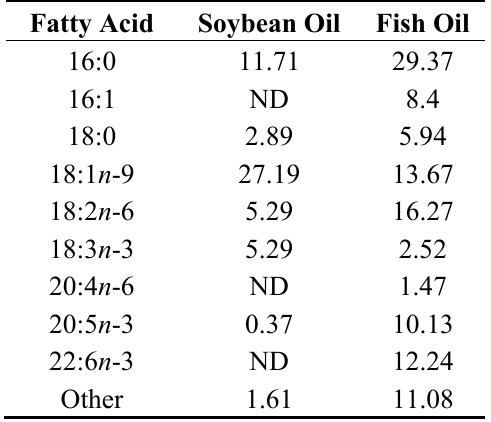
Table 1. Fatty acid composition of the oils used. Fatty Acid Soybean Oil Fish Oil